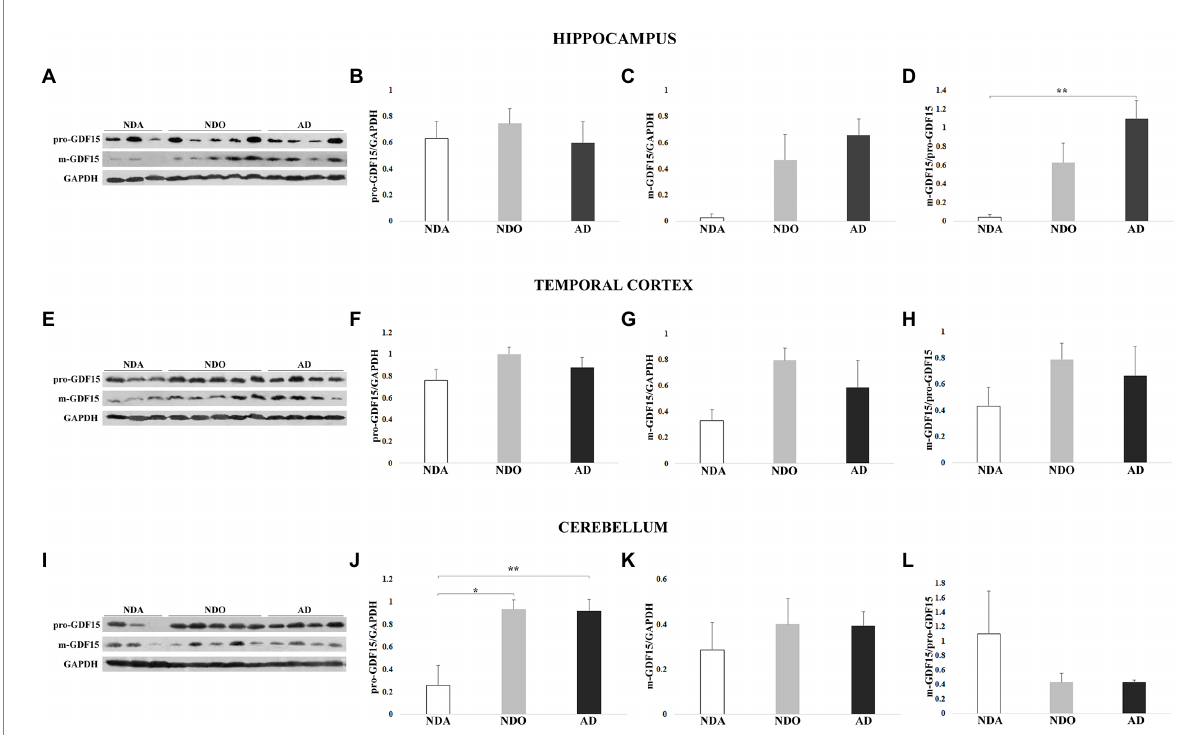
FIGURE 4 Western blotting analysis of GDF15 in different brain areas from 3 non-demented adults (NDA), 5 non-demented old subjects (NDO), and 4 AD patients (AD). (A) Representative immunoblotting image and (B) pro-GDF15, (C) m-GDF15, and (D) m-GDF15/pro-GDF15 ratio relative protein expression in hippocampus, (E–H) temporal cortex, and (I–L) cerebellum. The bars represent mean ± SE. Student’s t and one-way ANOVA tests with Bonferroni correction were applied for hippocampus and temporal cortex analyses. Kruskal–Wallis test and Bonferroni correction were applied for cerebellum analysis. Western blotting quantification was performed using ImageJ software and normalized to GAPDH expression. * p < 0.05. ** p <